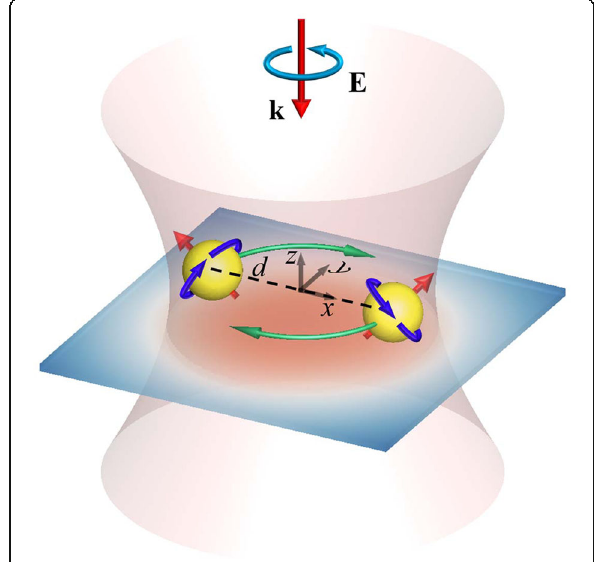
Fig. 1 Configuration of a pair of NPs with a supporting substrate, irradiated by a normally incident LH CP Gaussian beam of waist (w0). The central cross sections of these NPs are at the focal plane of the Gaussian beam, and d is the distance between the centers of NPs. The optomechanical responses are the longitudinal orbital rotation and longitudinal/transverse